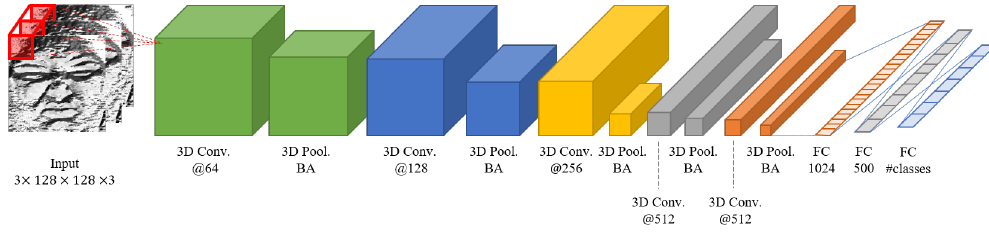
Figure 5. Appearance feature-based spatiotemporal